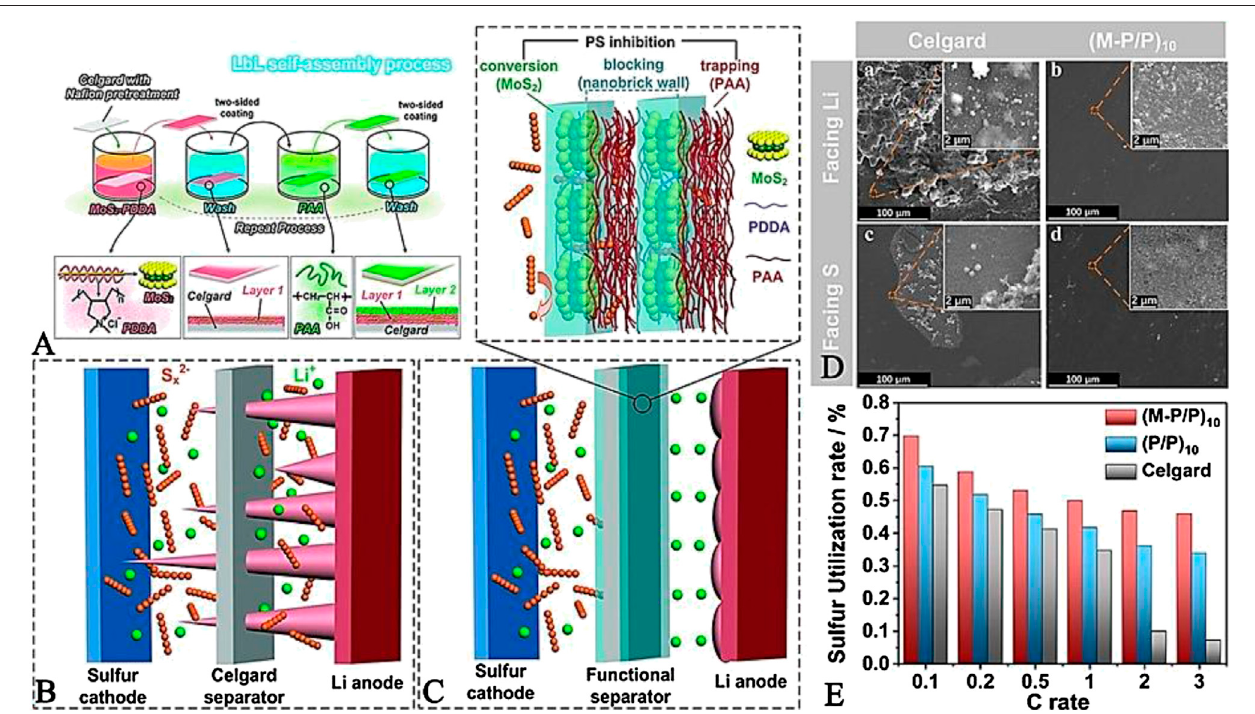
FIGURE 8 | (A) Schematic showing the M-P/P-coated separators self-assembly process (B, C) Schematic illustrations of the LSBs with Celgard and M-P/P- modi fi ed separator (D) SEM images of Celgard separator and M-P/P coated separator adjacent to Li anode and sulfur cathode after 500 cycles at 1 C (E) Sulfur utilization rate at various C-rates for different separators. Reproduced with permission from (Wu et al., 2018).